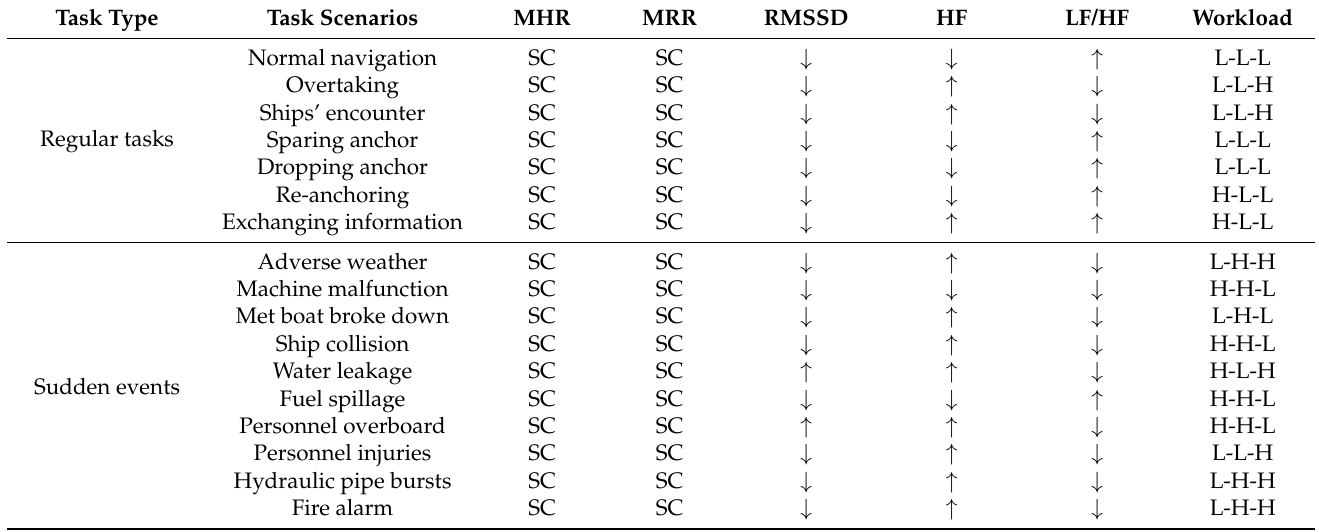
Table 4. Task scenarios combined with heart rate calibrated workload levels (e.g., subject 8 and